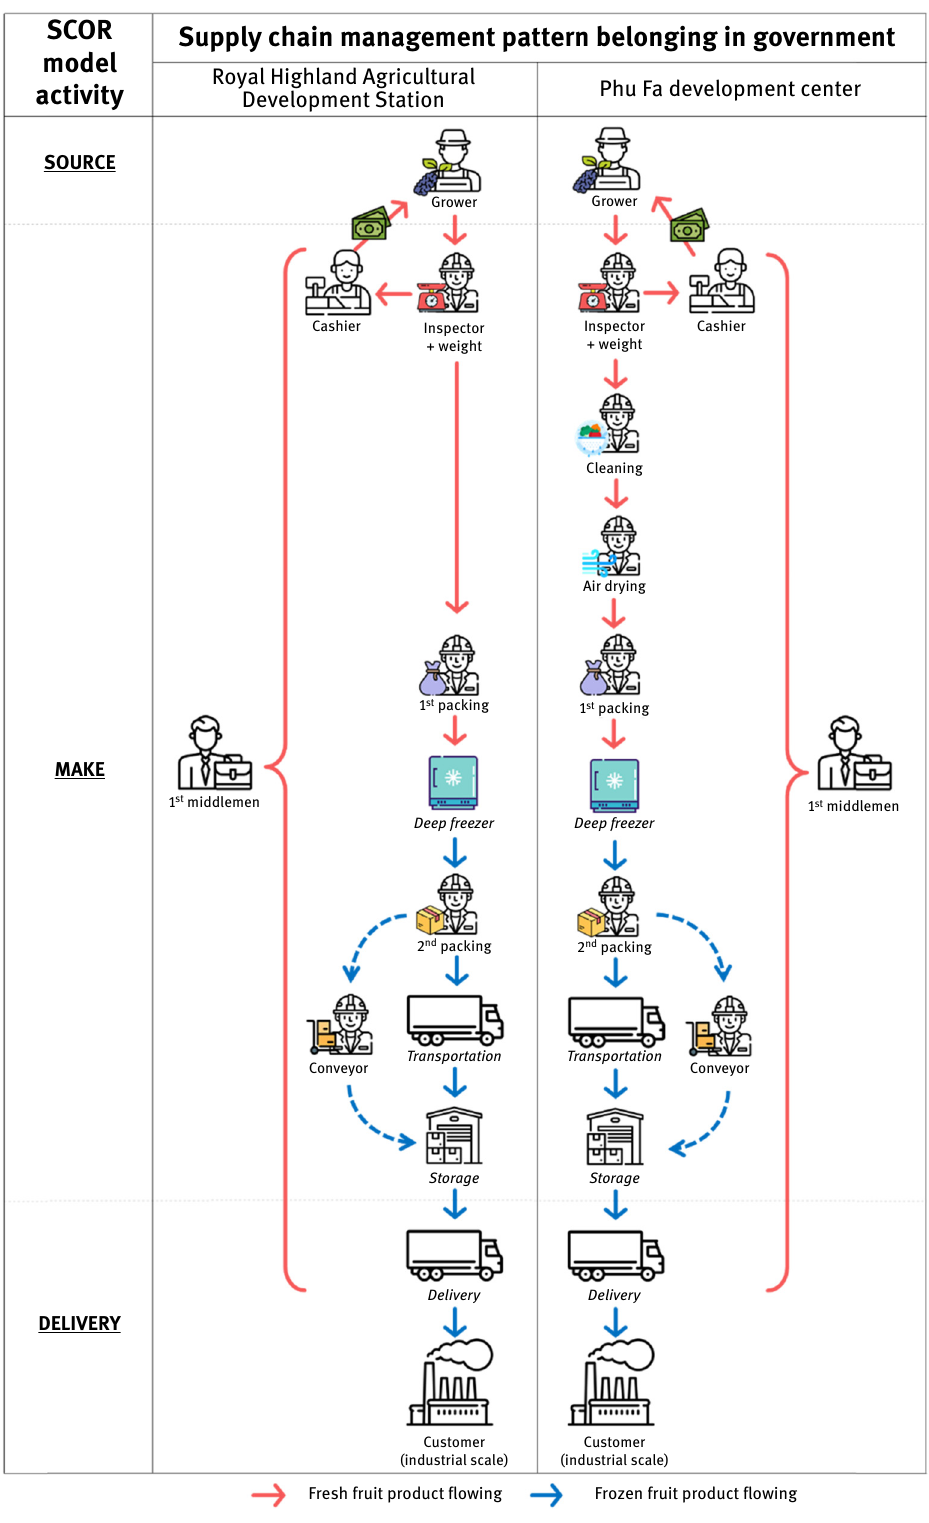
Figure 2: Mulberry supply chain processes at the Royal Highland Agricultural Development Station and Phu Fa development